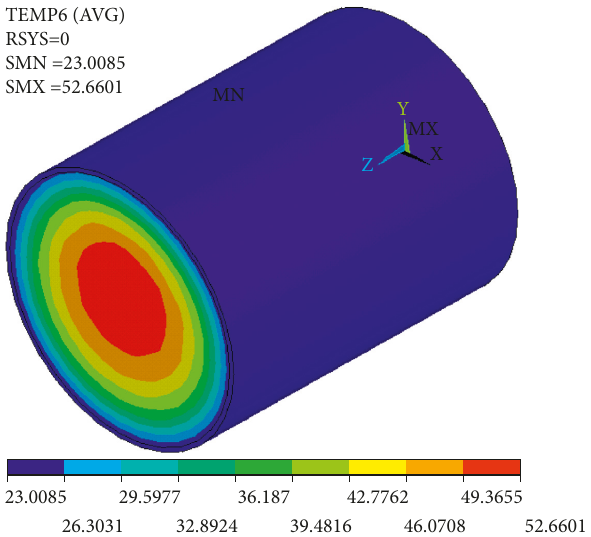
TEMP6 (AVG) RSYS=0 SMN =23.0085 SMX =52.6601